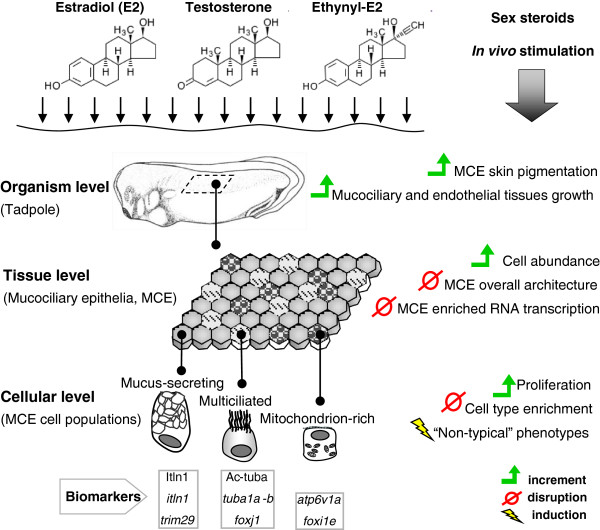
Overview of sex steroids impact on the mucociliary epithelium of
Xenopus
embryos.